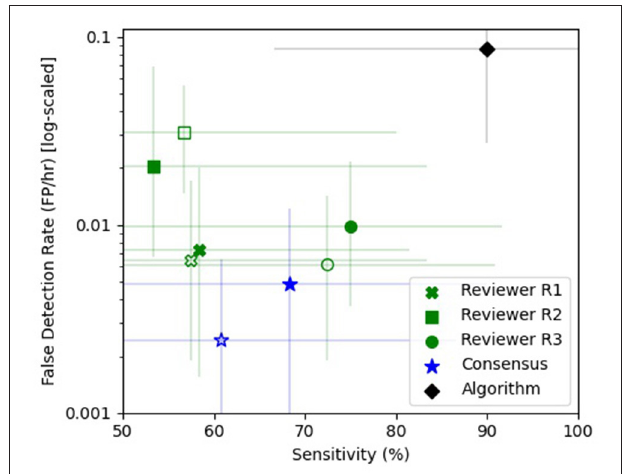
FIGURE 6 | Sensitivity vs. false detection rate. The sensitivity (%) and false detection rate (FDR—FP/h) are shown for the individual reviewers [green x (R1), square (R2), and circle (R3)], the consensus review (blue star), and the automated algorithm (black diamond). The unfilled markers denote the naive epileptologist review and the filled markers denote review with automated algorithm annotations as clinical decision support software (CDSS). Reviewers R1 (green x), R3 (green circle), and the consensus (blue star) showed improved sensitivity with CDSS at the expense of a higher FDR, while reviewer R2 (green square) had a reduced sensitivity and FDR with CDSS. The REMI automated seizure detection algorithm (black diamond) had a higher sensitivity than any one reviewer or consensus, with a higher false detection rate. The error bars are 95% confidence intervals using a bias-corrected and accelerated method (BCa, N = 1,000).